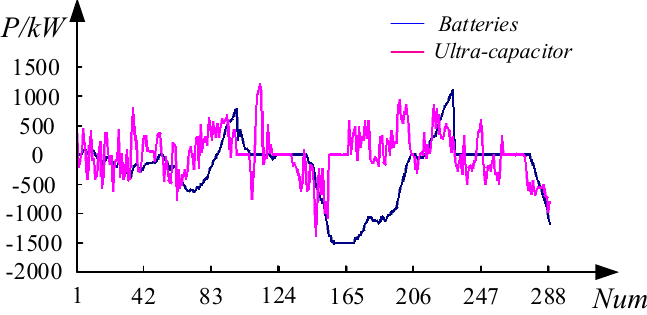
. . . HESS HESS . HESS HESS